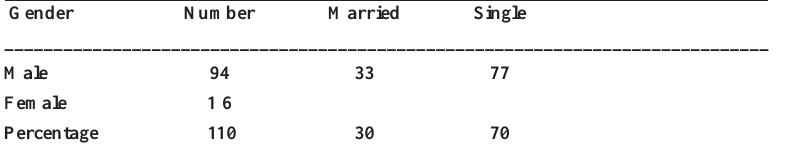
Frequencies and percentages of male / female and marital status of respondents